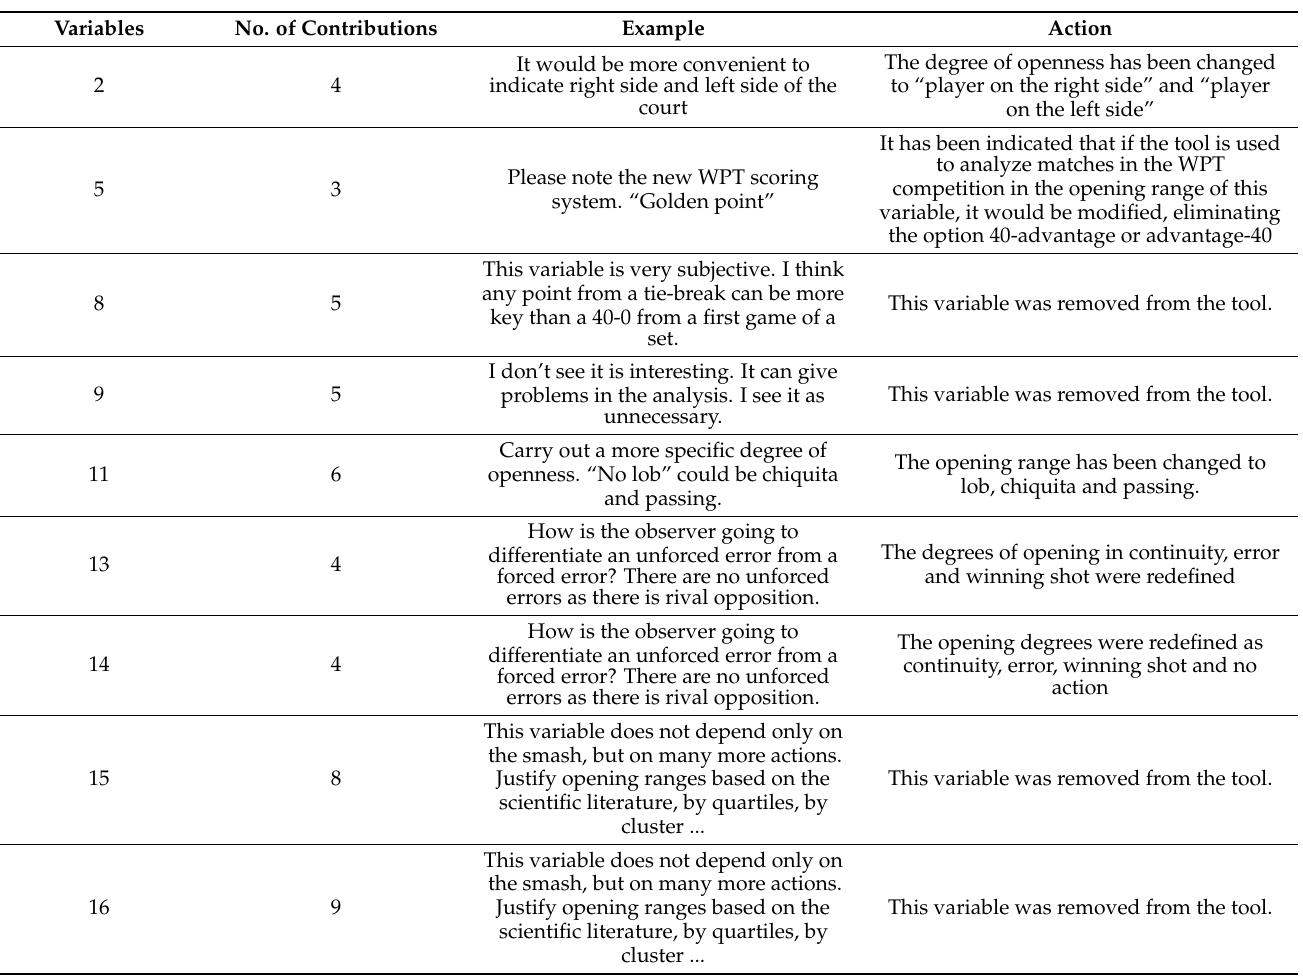
Table 6. Qualitative evaluations by the experts.